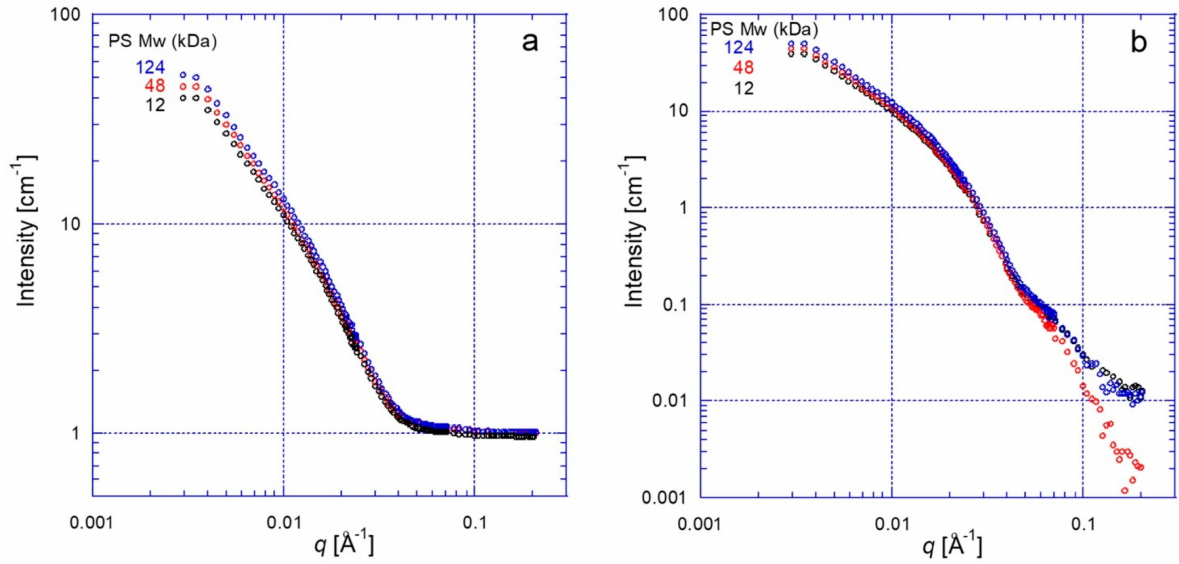
low-dose cryo-TEM imaging showed well-dispersed, intact tubes, but failed to reveal the presence of the adsorbed polymer on the surface of the nanotubes. SANS measurements were performed with dispersions in DMF solvents at two matching conditions 10% and 100% deuterated DMF-d7, which nearly match the S4VP polymer and the graphitic CNT walls, respectively. Figure 7a,b present the SANS patterns of the three MWCNT/S4VP dispersions with the block copolymers having three different PS block lengths, in the solvent containing 10% DMF-d7, before and after background subtraction, respectively. The patterns of all three hybrid types nearly overlap in the entire measurable q range, as expected by the matching of the polymer and solvent SLD. This renders the observed scattering to be due to the MWCNTS only, which are the same in all three dispersions. The variance at very high q may be due to issues of background subtraction.